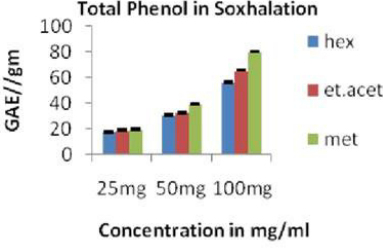
Fig. 2. Total phenolic content in soxhalation